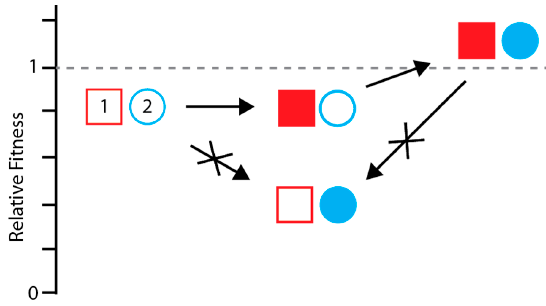
Figure 3. Epistasis can constrain adaptation. The ancestral identity of loci (1) and (2) are shown as unfilled red and blue shapes. A mutation at locus 2 mediates immune escape (filled circle) but is detrimental if it occurs on the ancestral background. Thus, a compensatory mutation at locus 1 (filled square) is required before the escape mutation, limiting the accessibility of the higher fitness genotype (filled square and filled circle). The compensatory mutation also becomes entrenched. Once the antigenic mutation arises, reversion of the compensatory mutation to its ancestral state (unfilled square) would cause a fitness decrease, even though it was initially neutral. Such interactions can occur within or between genes and involve more than two loci.